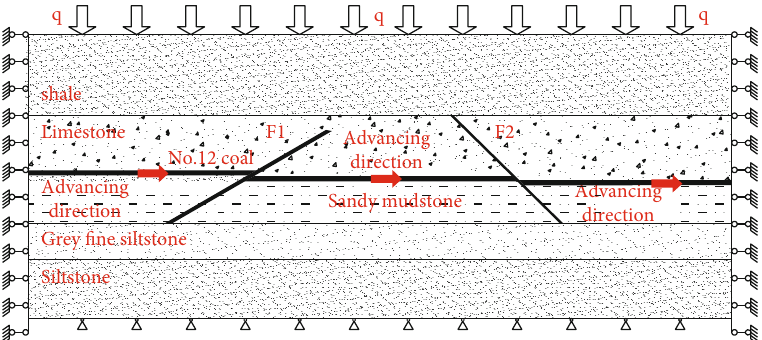
Figure 5: Schematic design of numerical model.